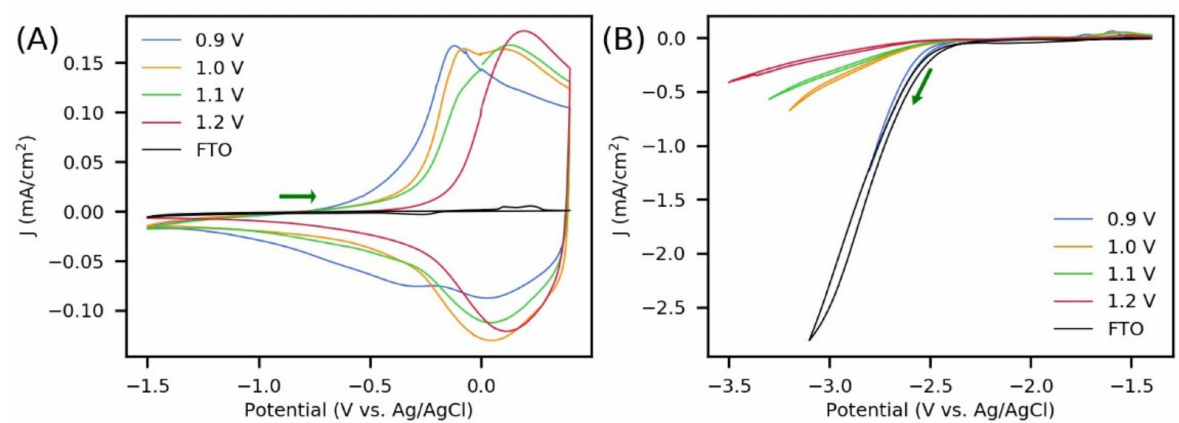
Figure 7. Cyclic voltammograms of polypyrrole films synthesized at 0.9 V, 1.0 V, 1.1 V, and 1.2 V on FTO substrates. Potential window for ( A ) oxidation and ( B ) reduction of PPy. In all cases, the electric charge supplied during polymerization was 42 mC/cm 2 . Electrolyte: 0.1 M NBu 4 PF 6 in acetonitrile, scan rate of 20